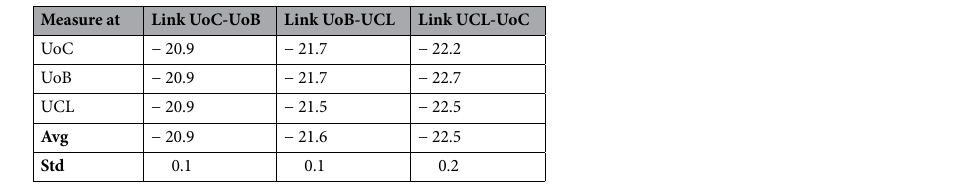
Table 3. Predicted NSR (dB) of virtual links, at 16 channel full load 21